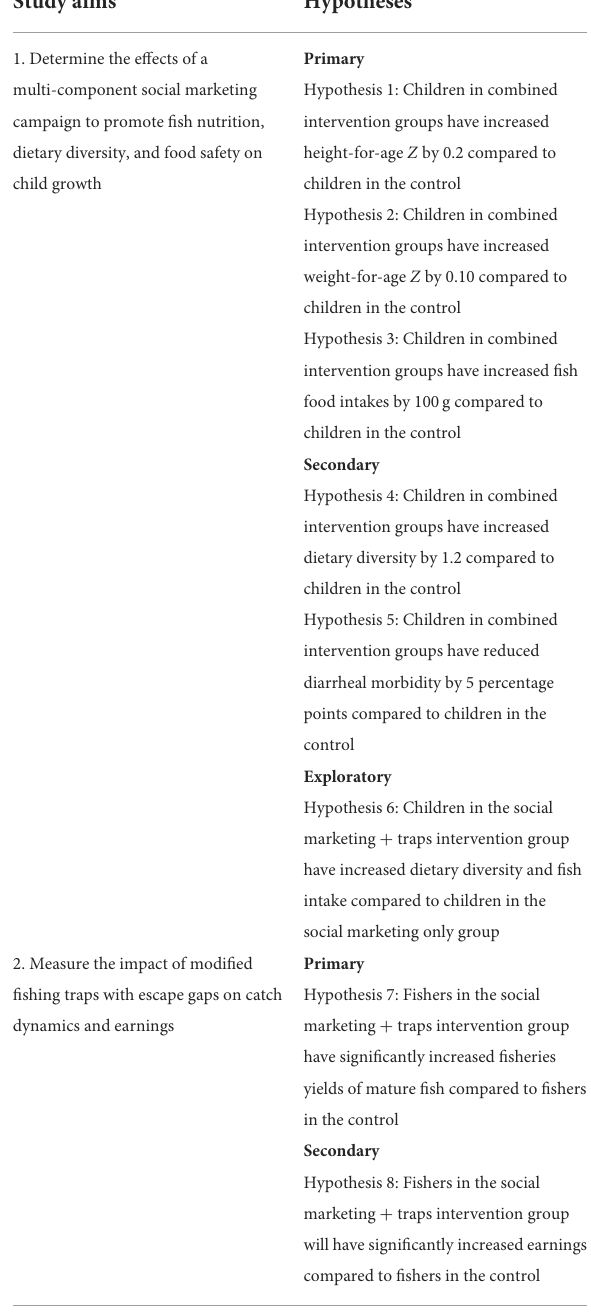
TABLE 1 Study aims and